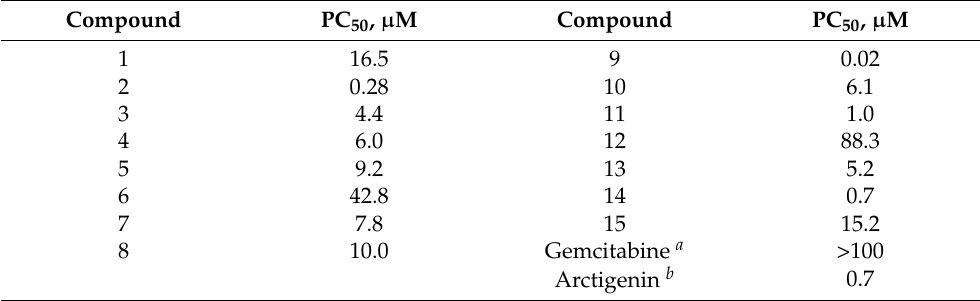
Table 2. Preferential cytotoxicity (PC 50 ) of compounds 1 – 15 against the PANC-1 human pancreatic cancer cell line in nutrient-deprived medium